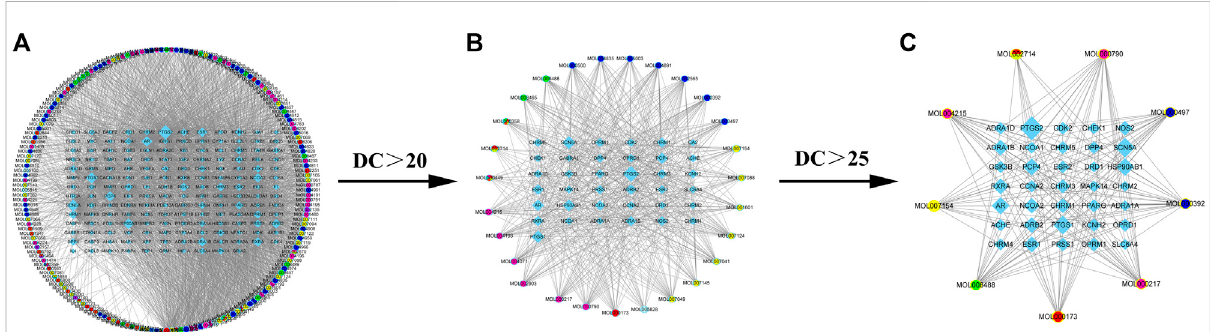
FIGURE 2 XLD active ingredient network and its molecular targeting relationship. (A) XLD formulae network of all active components and molecular targetingnetwork(drugnodesareroundandmolecularnodesarediamondshaped). (B) The56drugnodes(roundnodes;danshenisyellow,gancao isblue,goutengisgreen,yanhusuoispink, chenpiisred,andavariety ofmedicines aremixedcolors)and40molecular nodes(diamondshaped). (C) Drug-target network core: The nine drug nodes (round nodes; Salvia miltiorrhiza is yellow, licorice is blue, uncaria is green, Corydalis is pink, tangerine peel is red, and a variety of medicines are mixed colors) and 35 molecular nodes (diamond shaped). XLD, Xiaoliu Decoction; DC, degree